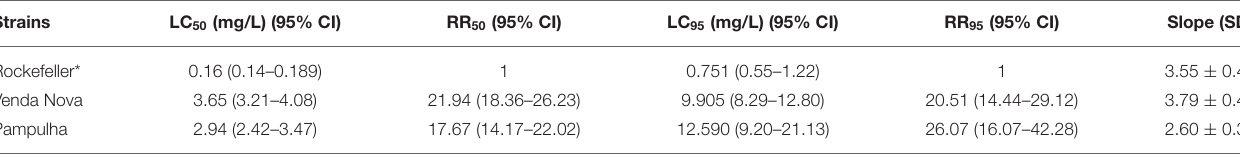
TABLE 2 | LC 50 and LC 95 for the technical grade deltamethrin insecticide (Bayer Brazil, 99.1%) in larvae of Aedes aegypti . Strains